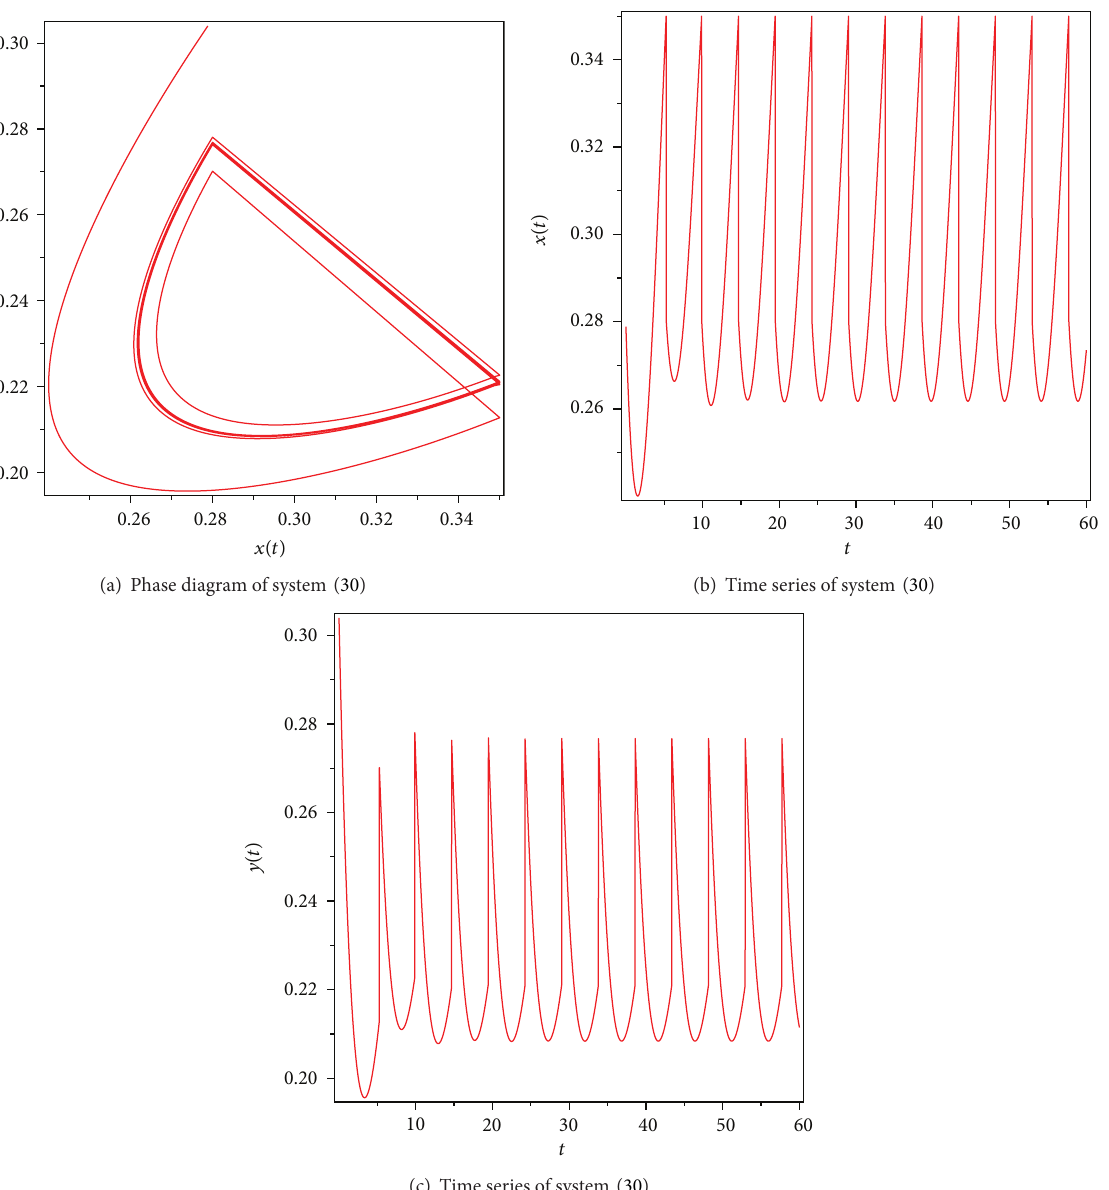
Figure 8: There exists a 1-periodic solution in the area Ω 1 = {(𝑥,𝑦) | ℎ 1 < 𝑥 < ℎ 2 } corresponding to Figure 4(b).